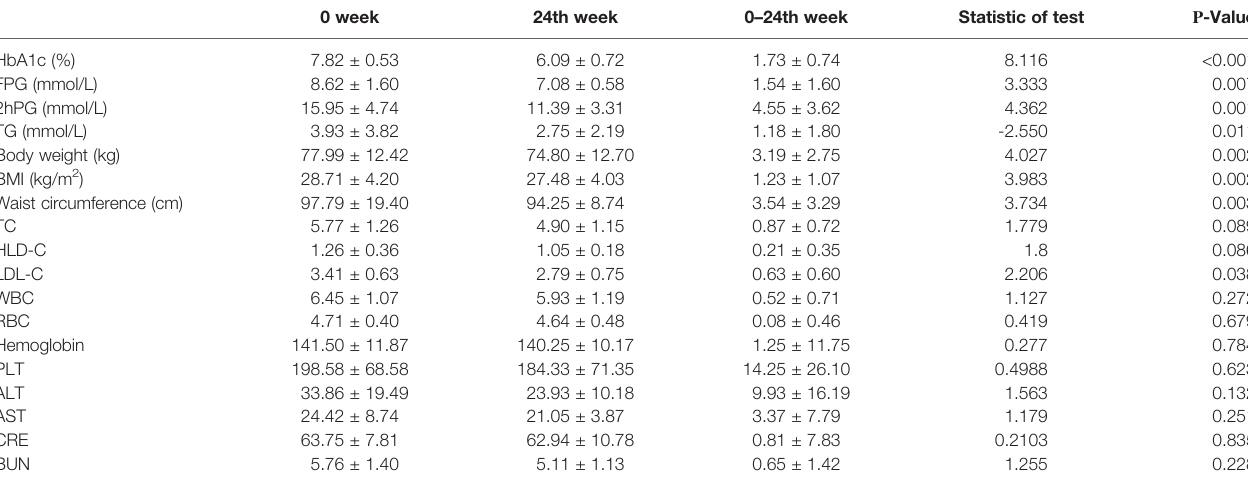
TABLE 4 | Comparison of clinical indicators before and after JTTZR intervention (n=12).